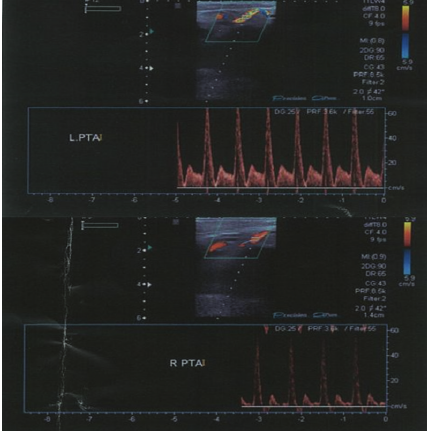
Figure 1: Arterial duplex evaluation shows flow in both posterior tibial arteries.